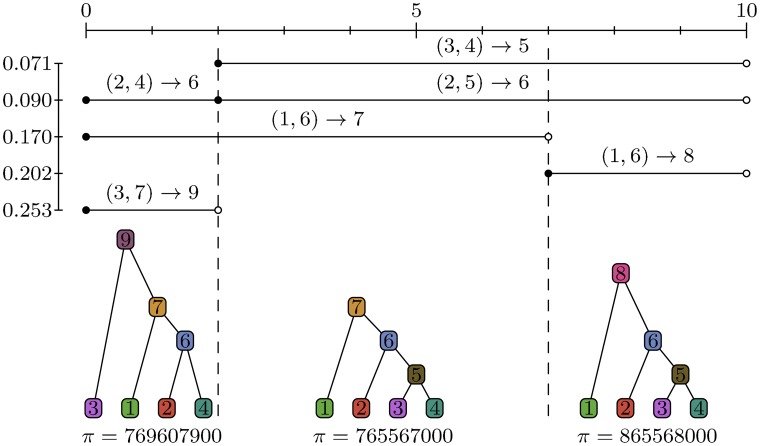
Coalescence records and corresponding marginal trees.The x-axis represents genomic coordinates, and y-axis represents time (with the present at the top). Each line segment in the top section of the figure represents a coalescence record; e.g., the first segment corresponds to the coalescence record (2, 10, 5, (3, 4), 0.071). The lower section of the figure shows the corresponding trees in pictorial and sparse tree form. We have omitted commas and brackets from this sequence representation for compactness.